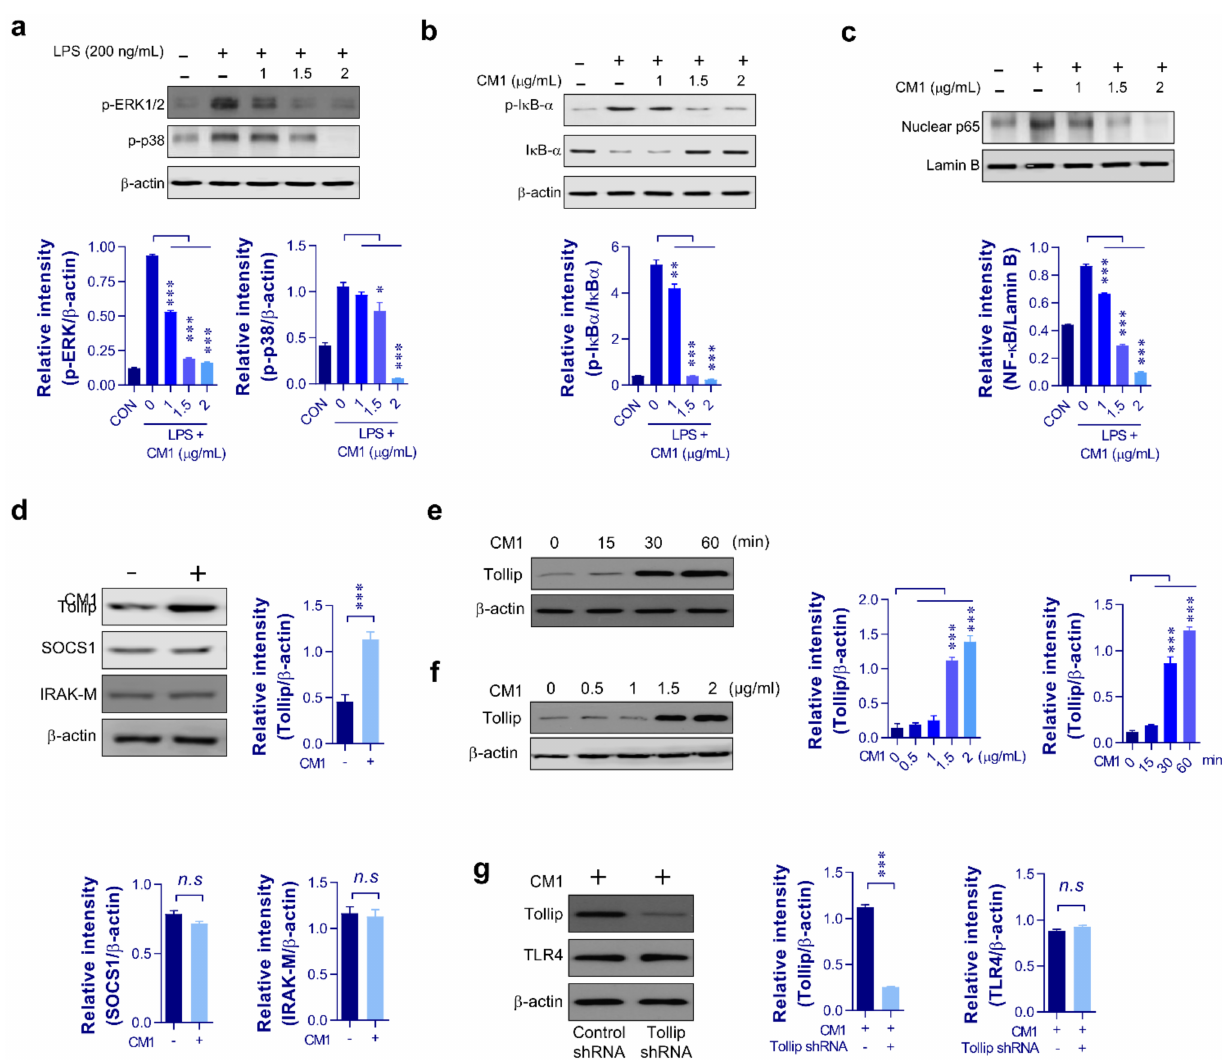
Figure 2. CM1-induced Tollip expression and inhibition of MAPK and NF- κ B activation in RAW264.7 cells. RAW264.7 cells were pretreated with CM1 (1, 1.5, and 2 µ g/mL) for 1 h and then stimulated with LPS (200 ng/mL) for 45 min ( a – c ). The cytosolic and nuclear fractions were subjected to SDS-PAGE, and immunoblotting was performed using specific Abs against p-ERK1/2, p-p38, p-JNK, p-I κ B- α , I κ B- α , and p65 NF- κ B. β -Actin and lamin B were used as the loading controls for the cytosolic and nuclear fractions, respectively. RAW264.7 cells were treated with CM1 (2 µ g/mL) for 1 h ( d ). Total cellular proteins were resolved by SDS-PAGE, and immunoblotting was performed using specific SOCS1, IRAK-M, and Tollip Abs. RAW264. 7 cells were treated with CM1 for the indicated time periods ( e ) or at indicated concentrations ( f ), and Tollip levels were measured by immunoblotting. RAW264.7 cells were transfected with the control and Tollip shRNA vectors ( g ). Cells were treated with CM1, and Tollip and TLR4 levels were measured by immunoblotting. One representative blot from three independent experiments is shown. Statistical analysis was performed by one-way ANOVA in conjunction with Tukey’s multiple test ( a – c , e ) or unpaired Student’s t test ( d , g ); n.s : no significance, * p < 0.05, ** p < 0.01, and *** p < 0.001. Abbreviations: MAPK, mitogen-activated protein kinase; NF, nuclear factor; Tollip, Toll-interacting protein; LPS, lipopolysaccharide; Abs, antibodies; p-ERK1/2, phosphor-extracellular signal-regulated kinase-1/2; p-p38, phosphor- p38; p-JNK; phosphor-c-Jun N-terminal kinase; I κ B, inhibitor of κ B; p-I κ B; phosphor-I κ B; SOCS1, anti-suppressor of cytokine signaling 1; IRAK-M, anti-interleukin-1 receptor-associated kinase; shRNA, short hairpin RNA; TLR4, Toll-like